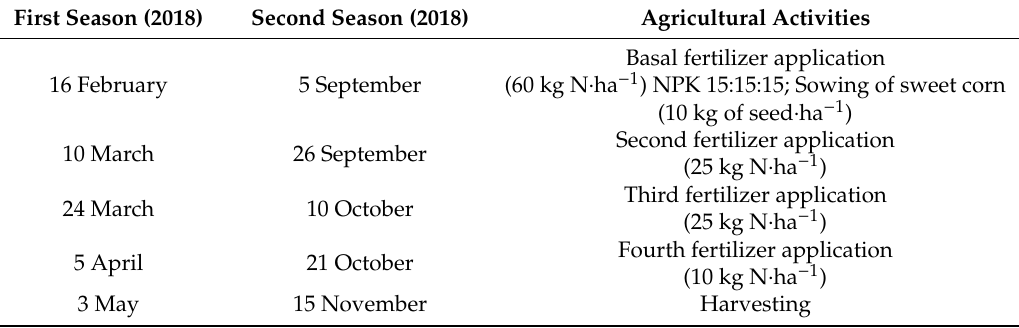
Table 2. Details of agricultural activities in the experimental field at MARDI during two sweet corn growing